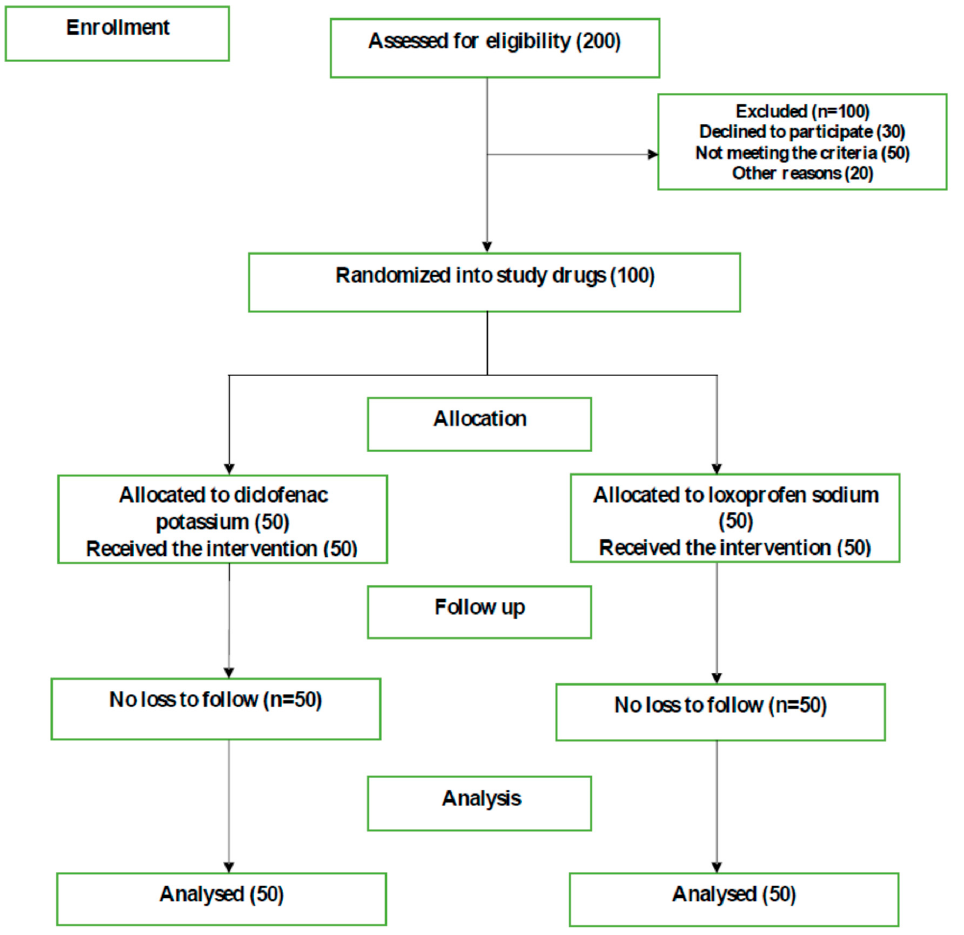
Figure 1. CONSORT flow chart diagram.